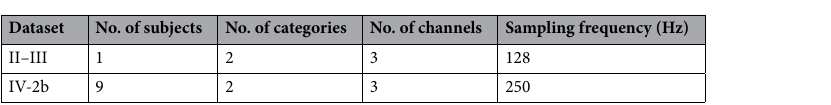
Table 1. Summary of datasets used in this